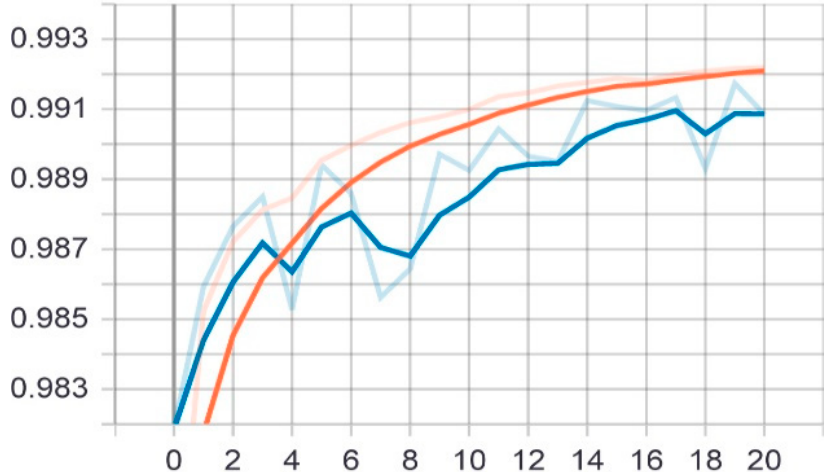
Figure 8. Accuracy (red line) and validation (blue line) convergence curves of the second model 20 over 20 epochs.